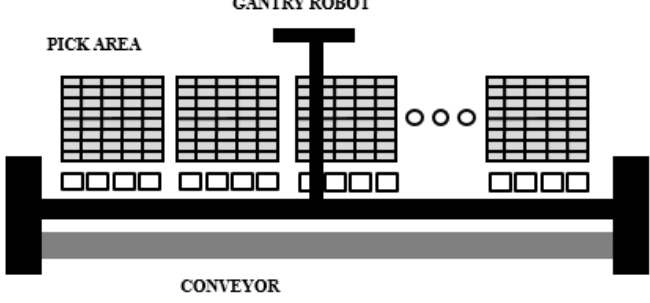
Figure 1. The layout of a pick zone.